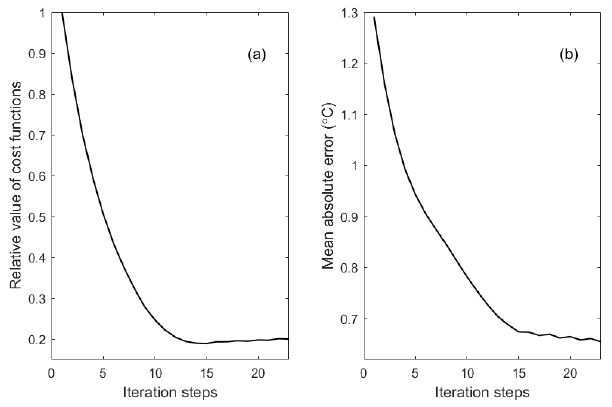
Figure 12. Cost function (a) and MAE (b) change related to the iteration steps.